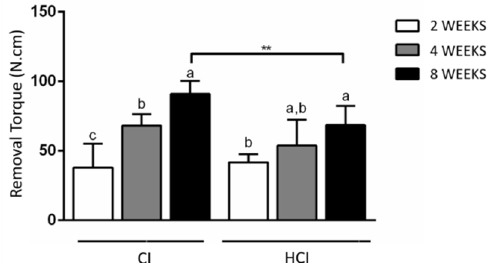
Figure 4. Mean and standard deviation of implant removal torque with different macrostructures. **p < 0.01 — Differences between groups of implants with different macrostructures — Paired t-test. Different letters represent different levels of statistically significant differences among the periods within each group (p < 0.05). One-way ANOVA complemented by the Tukey test.